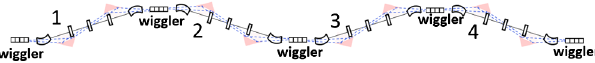
FIG. 5. A schematic of four cooling sections assembled back- to-back to obtain cascade amplified stochastic